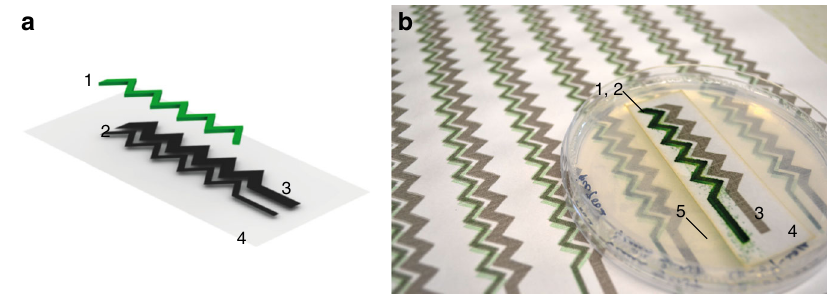
Fig. 5 Design of a fully printed BPV system. a Schematic representation (semi-exploded view) of the digitally printed bioelectrode module. 1: Printed photosynthetic organisms in green; 2: Printed CNT anode; 3: Printed CNT cathode; 4: Paper substrate. The one module consists of one zigzag anode and one zigzag cathode with surface areas 1.36 cm 2 and 2.73 cm 2 , respectively. b Photograph of A4-size arrays with freshly printed Synechococcus cells, compared to the incubated module grown on an agar plate for 3 days. (Note the enhanced green colour of the growing cyanobacteria.) 1 – 4 are the same as a and 5 is the solid medium